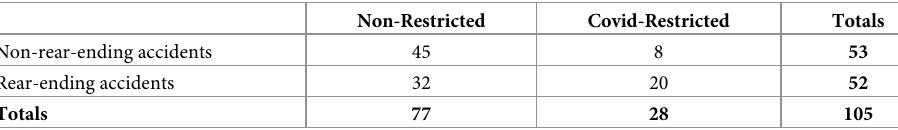
Table 3. Accident types during Non-Restricted vs Covid-Restricted